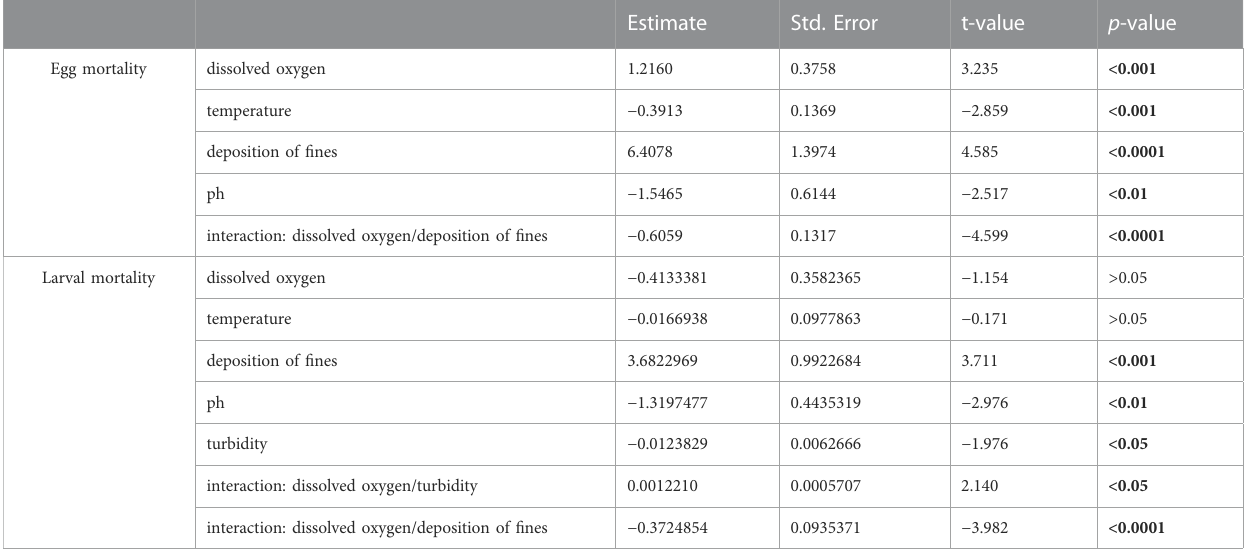
TABLE 6 Statistical output of the two best fi tting general linear mixed effects models (GLMMs) including the predictor variables dissolved oxygen, temperature, deposition of fi nes and pH for egg mortality and dissolved oxygen, temperature, deposition of fi nes, pH and turbidity for larval mortality. In both GLMMs spawning ground was set as random effect and interactions between dissolved oxygen and the deposition of fi nes were considered. In the GLMM for larval mortality was additionally the interaction between dissolved oxygen and turbidity considered since this led to a better fi t. Values in bold indicate statistically signi fi cant differences.